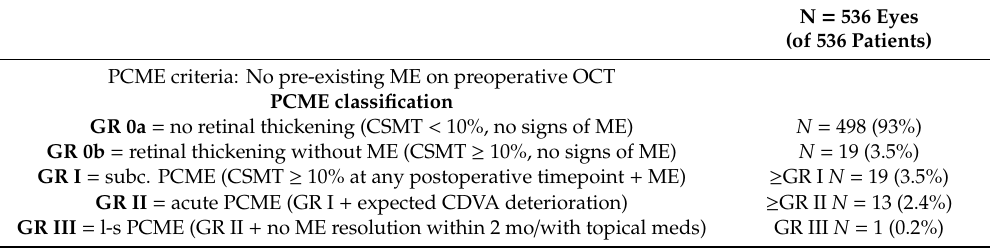
Table 1. Distribution of pseudophakic cystoid macular edema (PCME) within 3 months from cataract surgery.